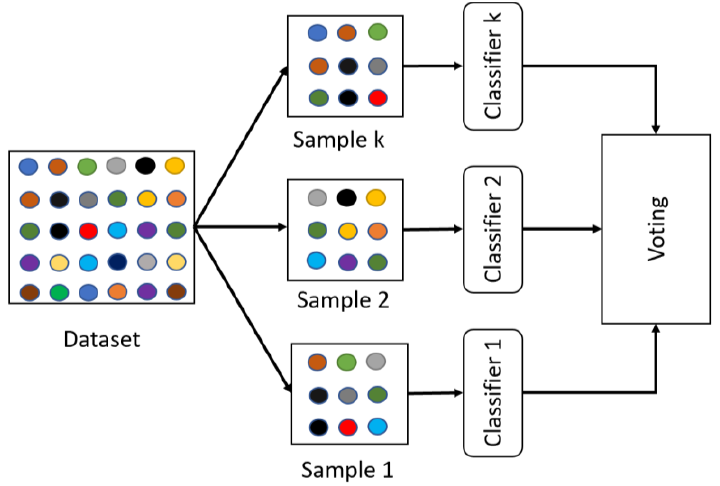
Figure 5. Bagged Trees.